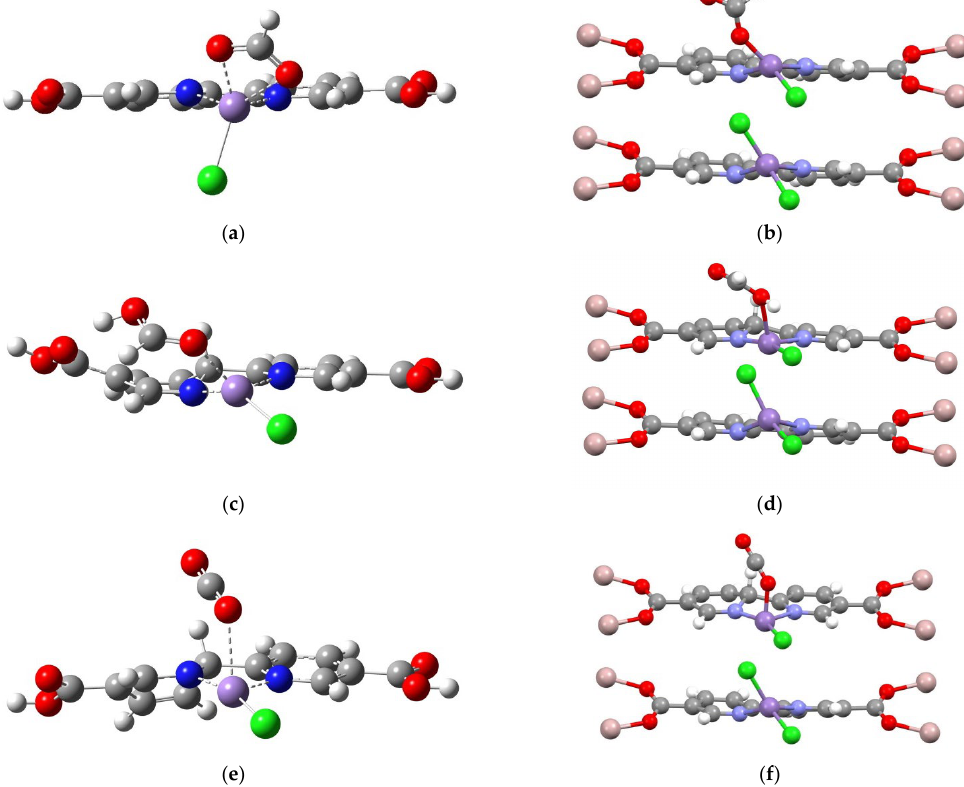
Figure 7. Schematic comparisons of LMnCl(HCO 2 ), HLMnCl(HCOOH), and HLMnCl(CO 2 ) intermediates using the molecular ( a – c ) and periodic ( d – f ) models, respectively.